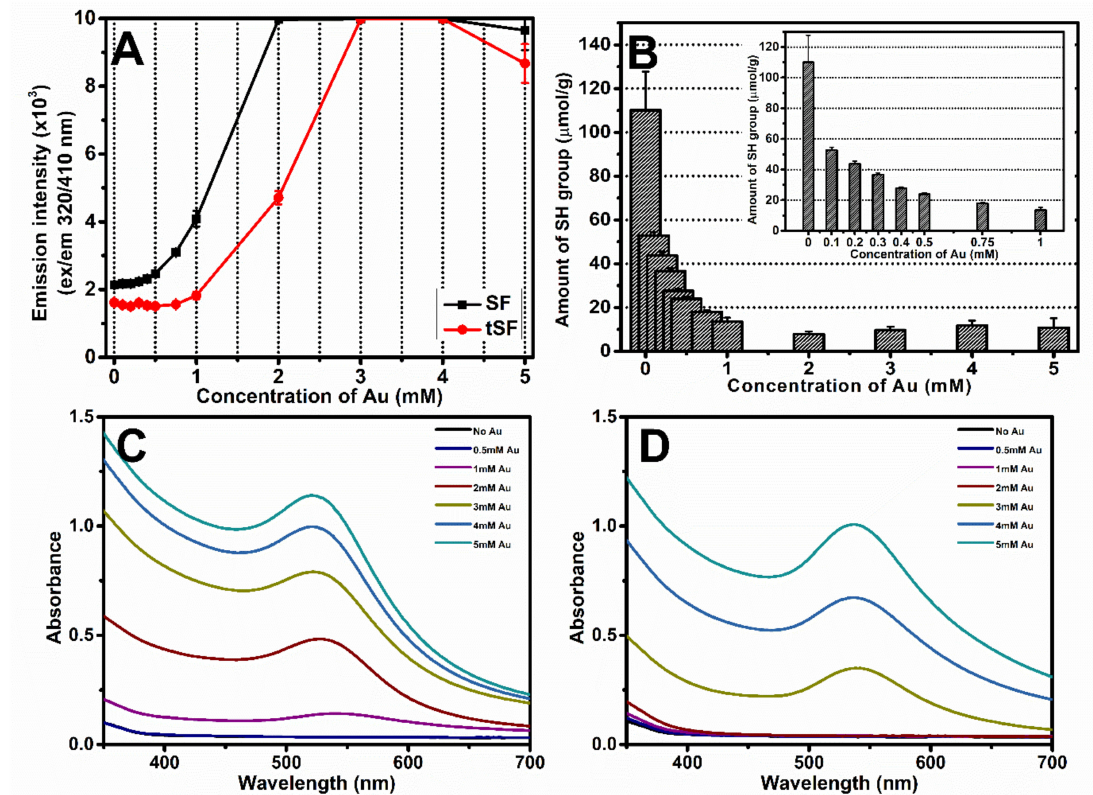
Figure 3. ( A ) Fluorescence measurements (excitation wavelength = 320 nm, emission wavelength = 410 nm) of SF and tSF, corresponding to the formation of dityrosine, after the addition of Au 3 + at di ff erent concentrations, ( B ) Amount of available sulfhydryl (SH) groups in tSF in a presence of di ff erent amounts of Au 3 + . The inset shows the results for Au 3 + concentrations below 1 mM. UV–vis absorbance spectra of the mixtures of ( C ) 1% SF and ( D ) 1% tSF at di ff erent Au 3 + concentrations, presenting the surface plasmon resonance band of gold nanoparticles